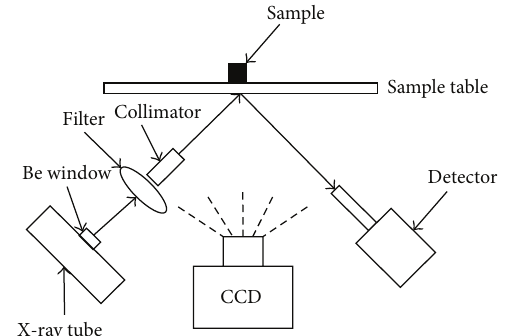
Figure 2: Structural diagram of the light path subsystem.